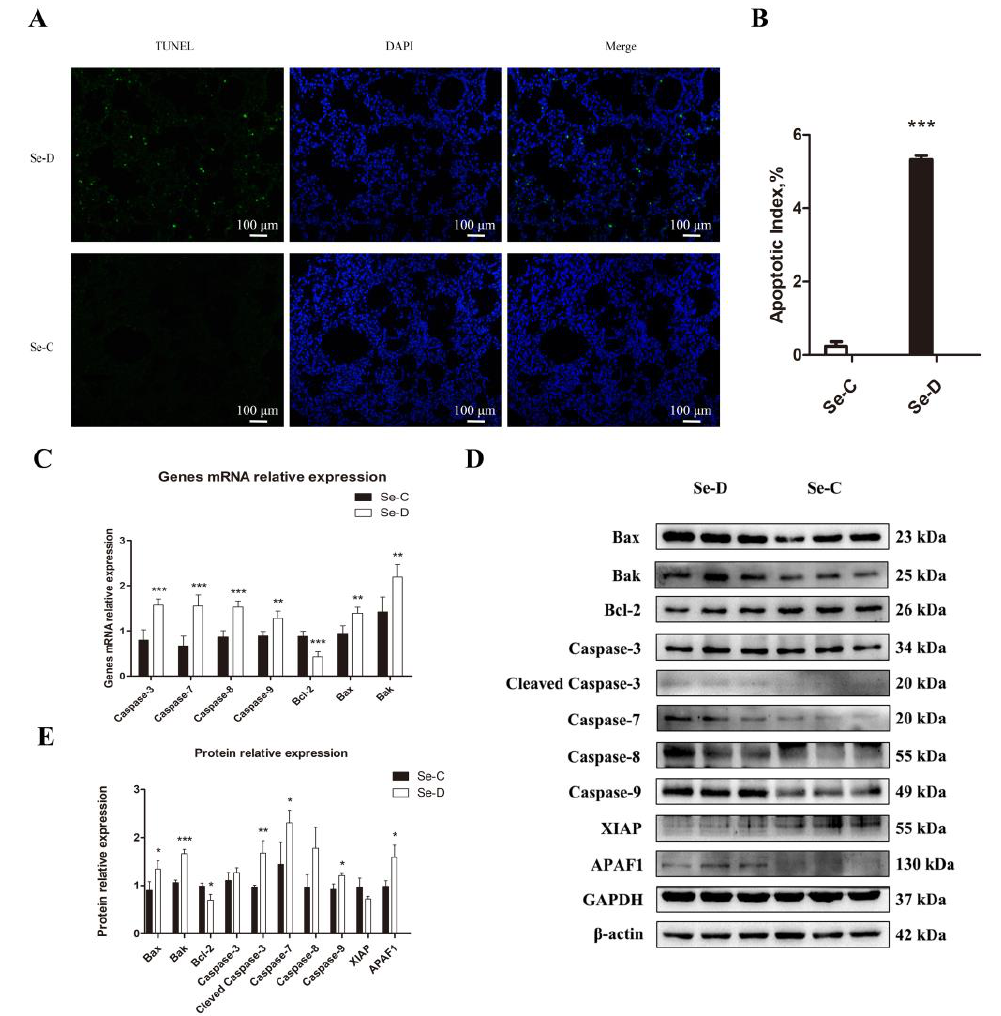
Figure 4. TUNEL staining ( A ) demonstrates the effect of Se deficiency on apoptosis in calf lung. ( B ) Apoptotic index of Se-C and Se-D groups. ( C ) mRNA expression of genes involved in apoptosis. ( D , E ) Expression of apoptosis-related proteins and their quantification. The mean ± SD is used to present the data above, n = 5 calves per group (except for WB n = 3). * p < 0.05, ** p < 0.01, *** p < 0.001.